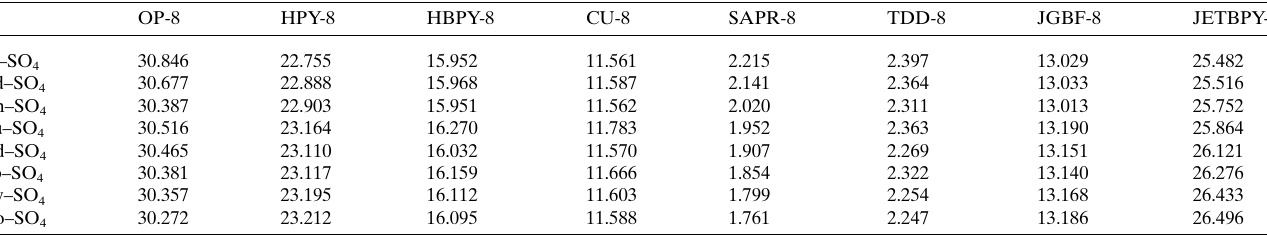
Table 3 Continuous shape calculations for octacoordinated Ln 3+ ions in 1 obtained with Shape 2.1 software (Casanova et al. , 2005).